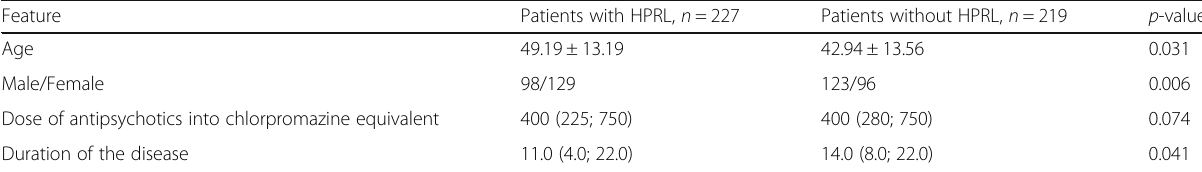
Table 1 Demographic and clinical features of patients with schizophrenia with and without HPRL Feature Patients with HPRL, n = 227 Patients without HPRL, n =